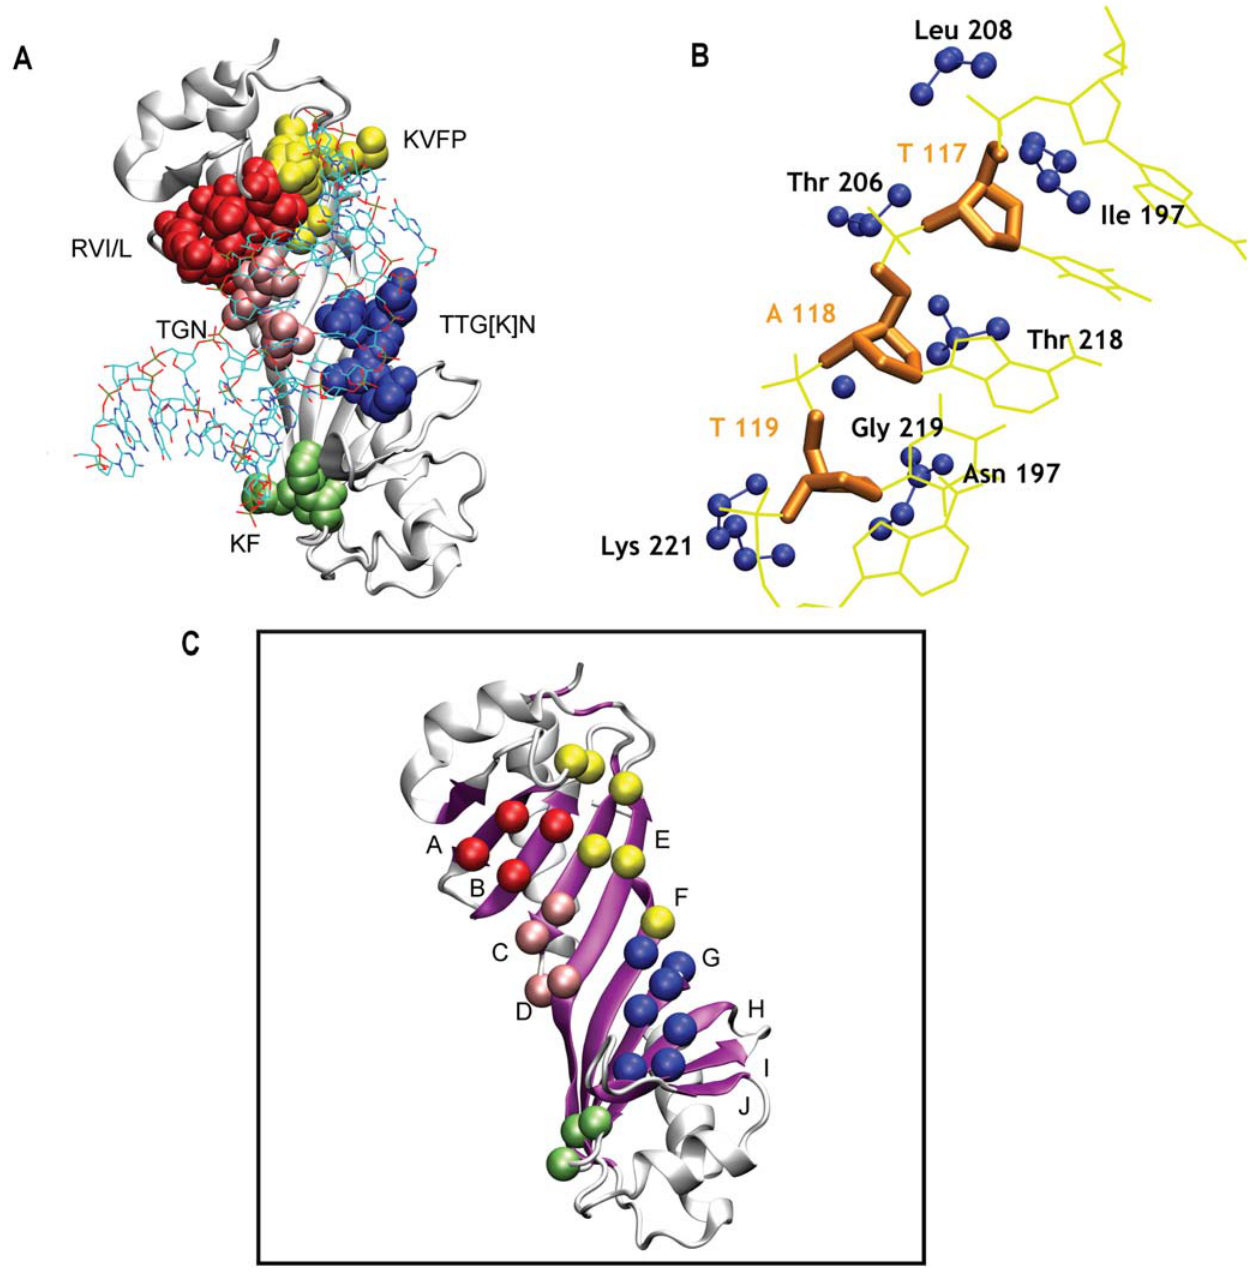
Figure 3. Protein-deoxyribose (P-S) clusters in b -sheet group. (a) Different P-S clusters in the TATA binding protein (1tgh) (at MEC 7%) are shown in different colors with their amino acid composition. (b) A P-S cluster is shown in detail to reveal the tight interactions between the amino acids (blue) and the deoxyribose (orange) of the nucleotides. (c) Only the C a of the amino acids of the P-S clusters is highlighted in the sheets named from A to J. feature of the P-p hubs of all the b -hairpin members is the absence of this hub in the main b -hairpin region. The positions of the P-p hubs vary with respect to the interacting b -hairpin in this group. For, e.g., Arc protein/DNA complex (1bdt) and Met Repressor/ DNA Complex (1cma) has P-p hubs in the flanking region adjacent to the b -hairpin (Figure 5), whereas Integration Host Factor/DNA Complex (1ihf) has the hubs scattered around the b - hairpin interaction region. The P-p hubs in T Domain-DNA complex (1xbr) are located on either ends of the complexed DNA.